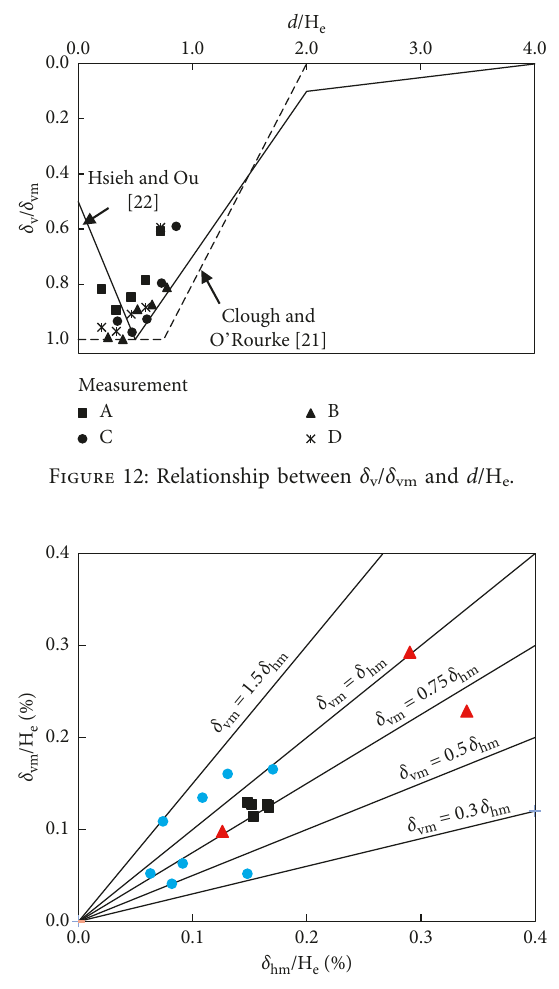
Figure 13: Relationship between the maximum lateral displace- ment of wall and the maximum ground surface